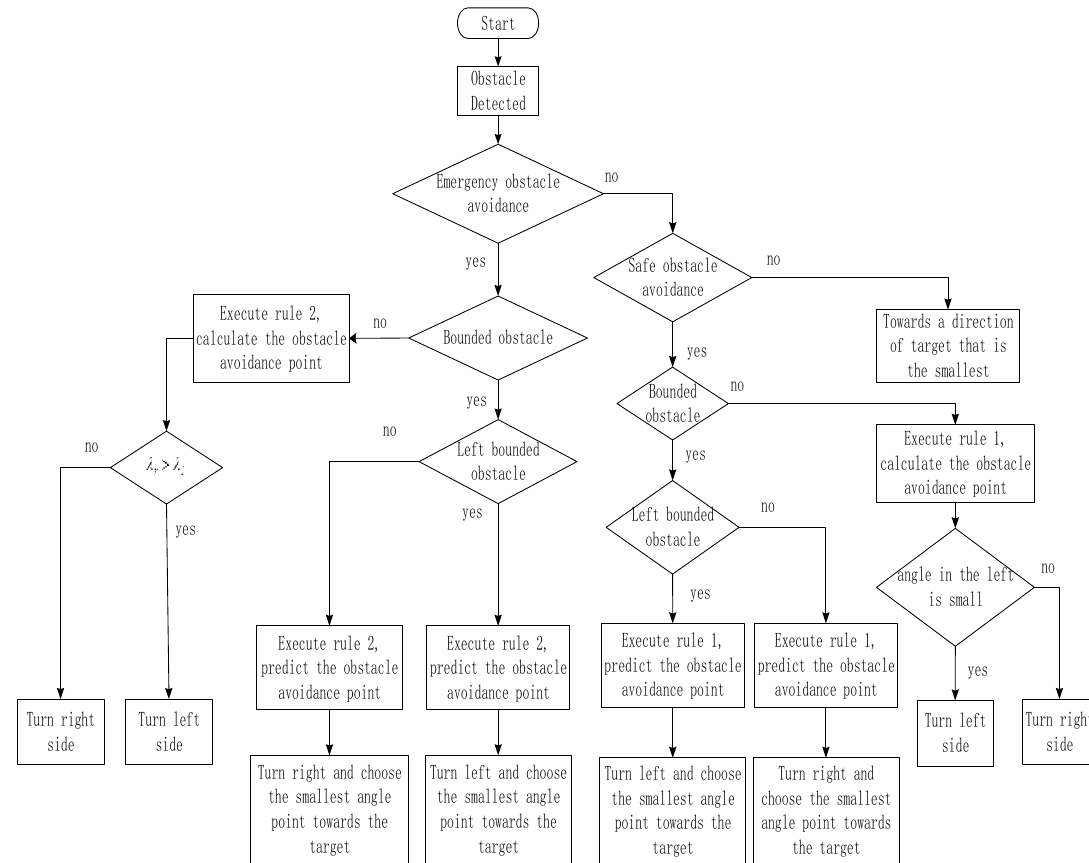
Figure 8. The obstacle avoidance rule shown by a